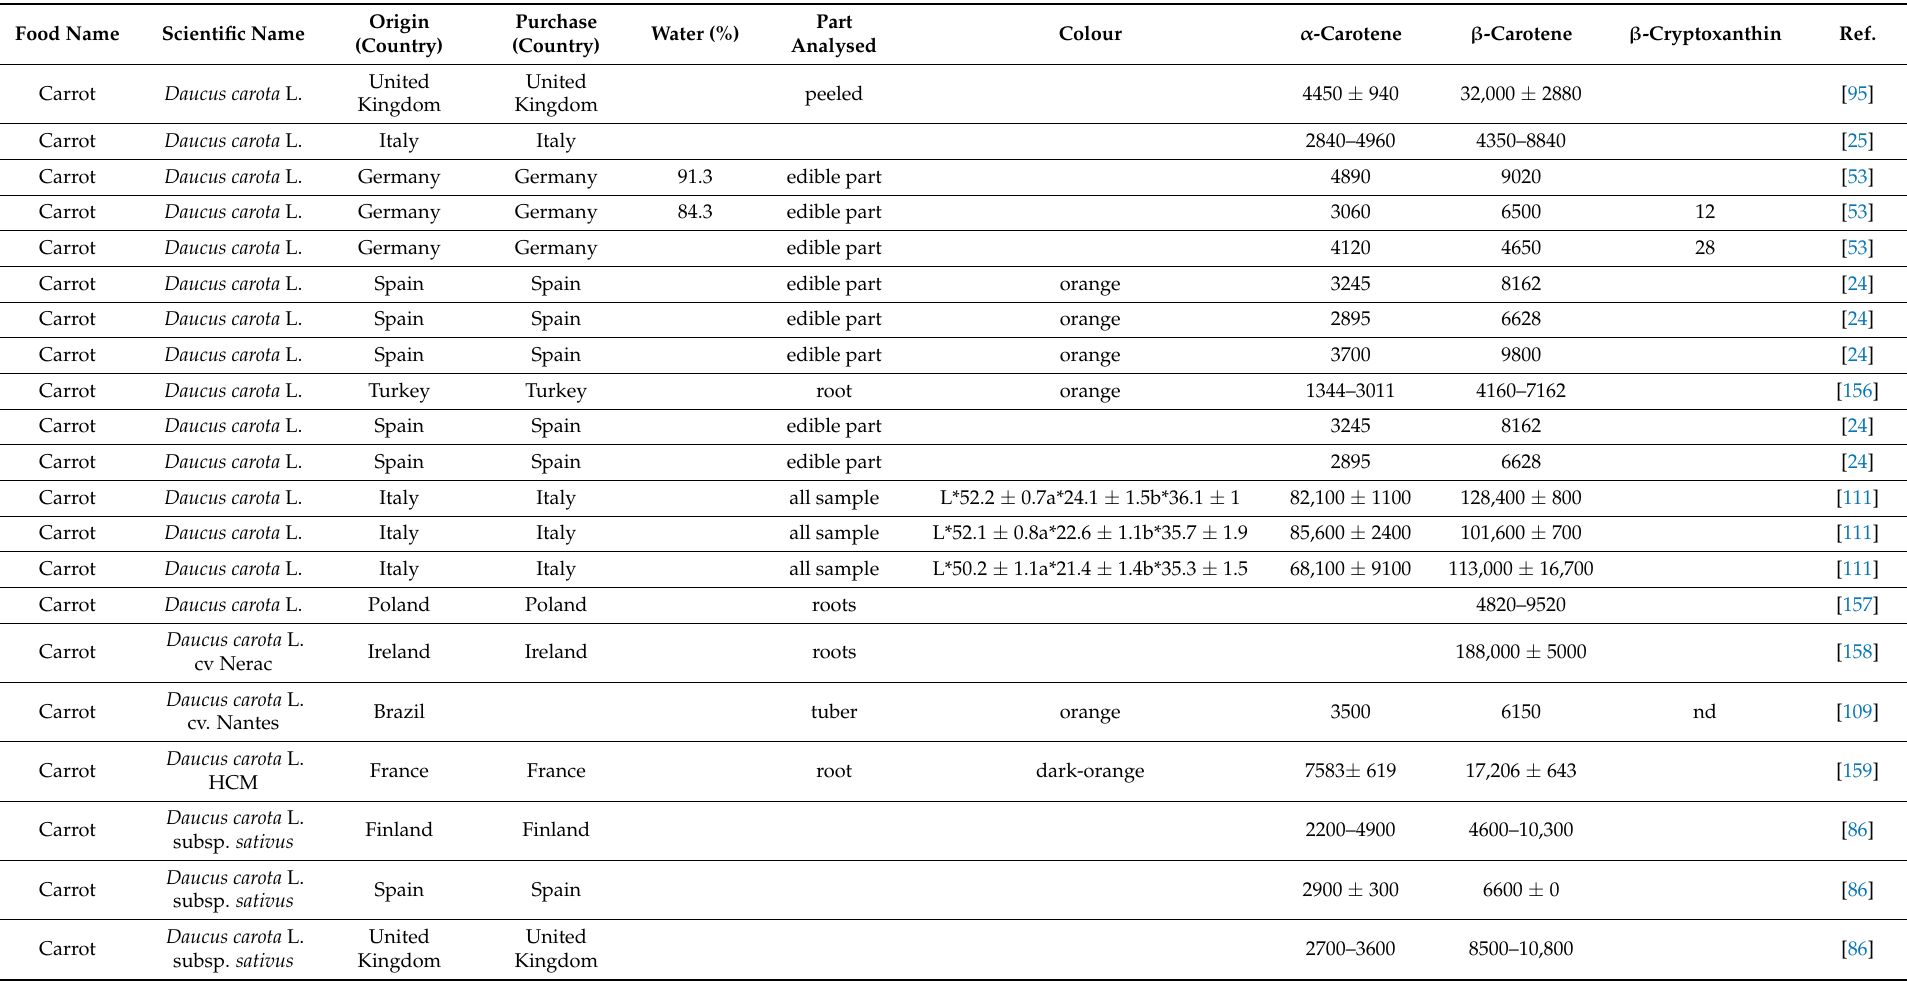
Table A1. Root and tuber vegetables (excluding starchy- and sugar-) (A00QF) ( µ g/100 g).